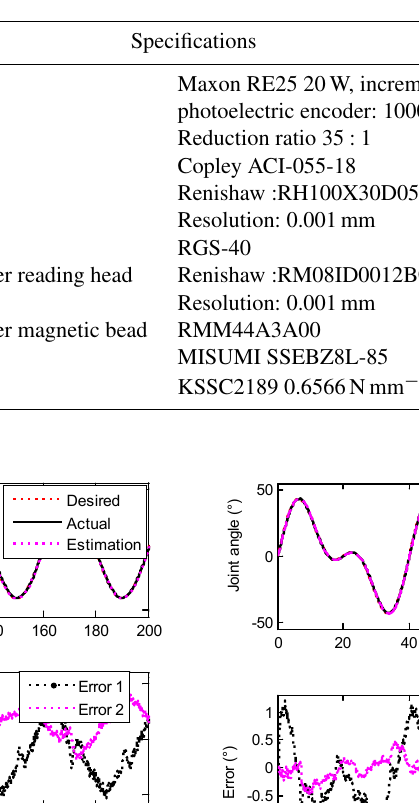
Figure 11. The control block diagram with a joint angle estimator. Table 1. Specifications of the experiment system.